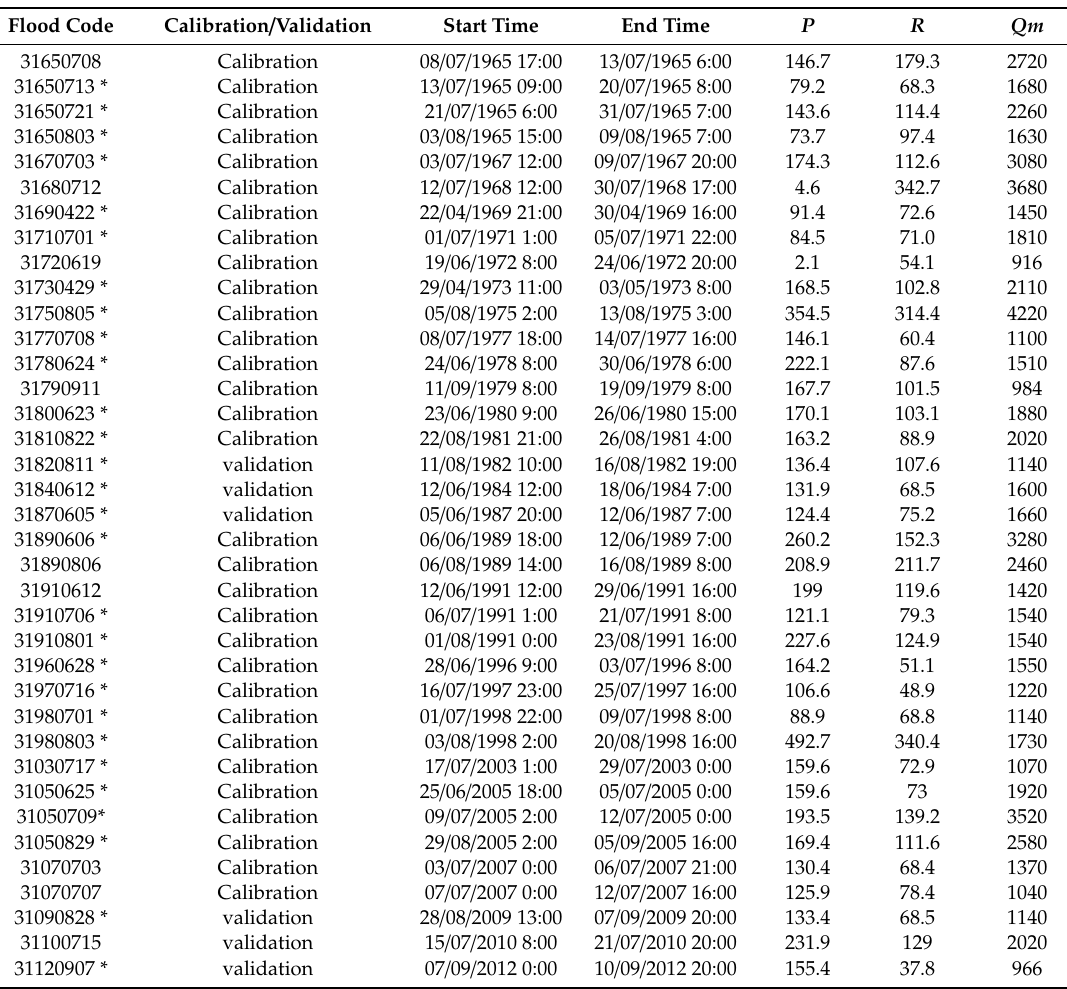
Table 5. The flood events in Dapoling